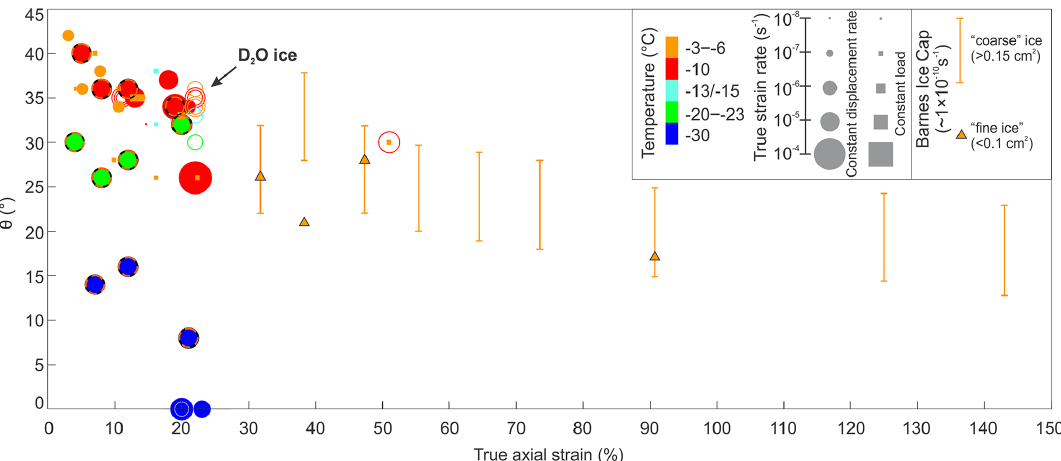
Figure 13. Plot of the relationship between the opening angle, θ , of the cone-shaped c -axis CPO and the true strain. The data come from this study and the literature (Table 4). The data from naturally deformed ice (Hooke and Hudleston, 1981) are illustrated by bars with whiskers (cover uncertainty range of the open angle) for “coarse” ice and triangles with black edges for “fine” ice. The data from constant displacement rate experiments on D 2 O ice (Piazolo et al, 2013; Wilson et al., 2020) are illustrated by hollow circles. The deformation of D 2 O ice at − 7 ◦ C is a direct analogue for deforming H 2 O ice at − 10 ◦ C (Wilson et al., 2019). The data from constant displacement rate experiments on H 2 O ice (this study, Vaughan et al., 2017; Qi et al., 2017; Craw et al., 2018) are illustrated by filled circles. Data from this study are highlighted by orange and black edges. The data from constant load experiments (Jacka and Maccagnan, 1984; Jacka and Li, 2000; Montagnat et al., 2015) are illustrated by solid squares. Each marker is sized and coloured by the corresponding true strain rate and temperature, respectively. For all experiments the strain rate shown is the strain rate at the end of the experiment.